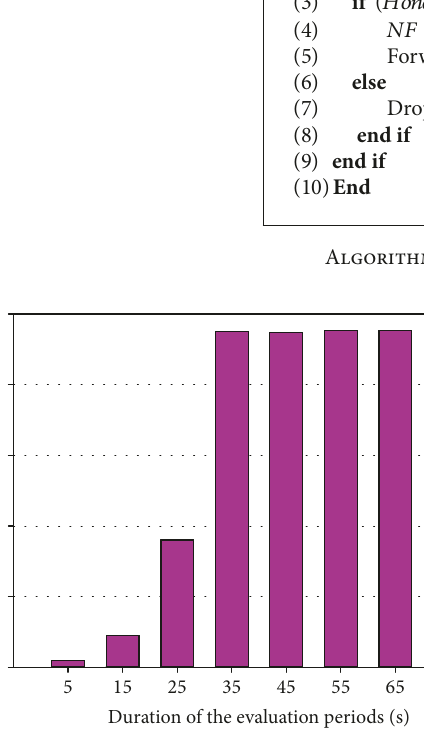
Figure 4: Selection of the adequate evaluation periods (𝑡 𝑥 ) .